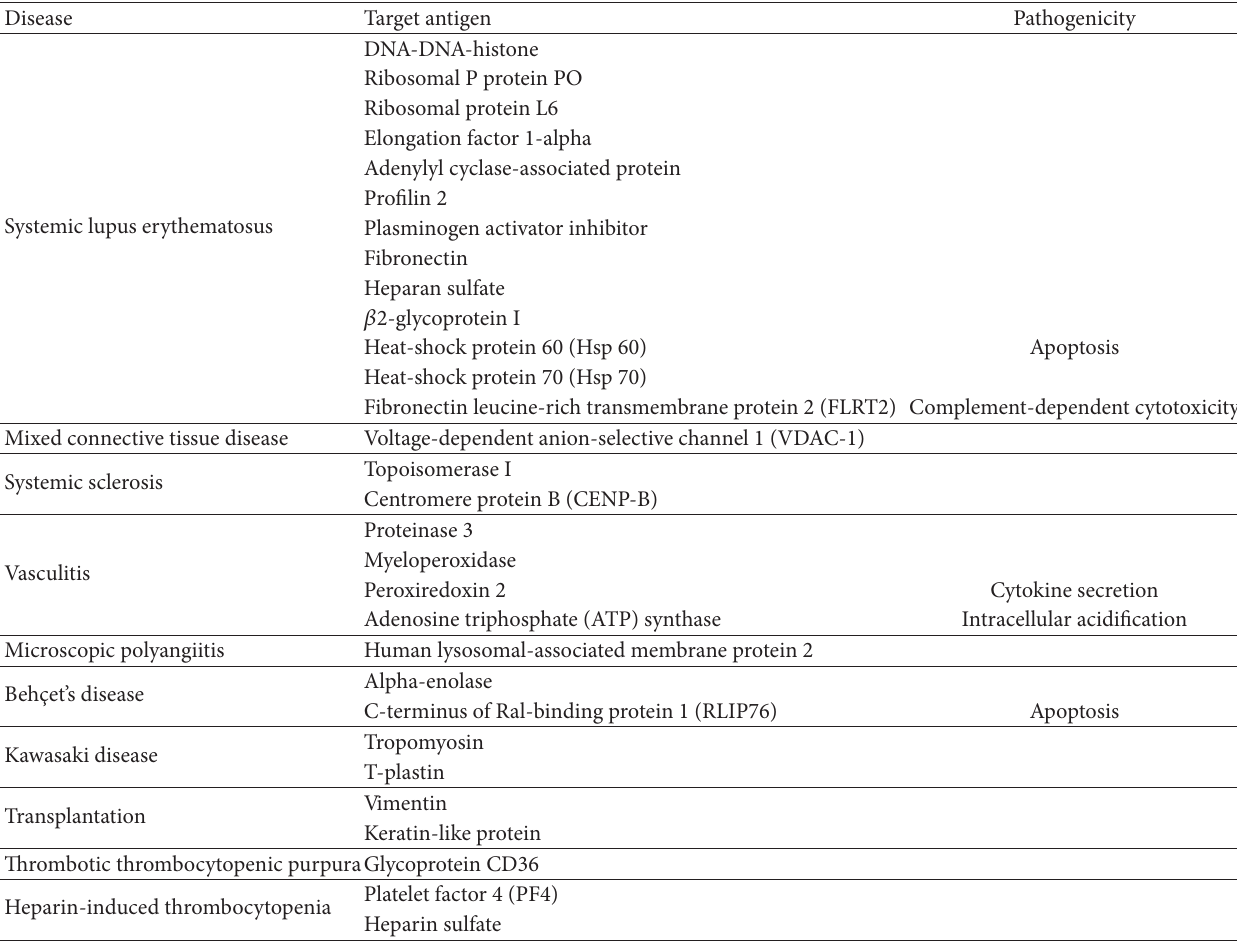
T 2: Reported target antigens of anti-endothelial cell